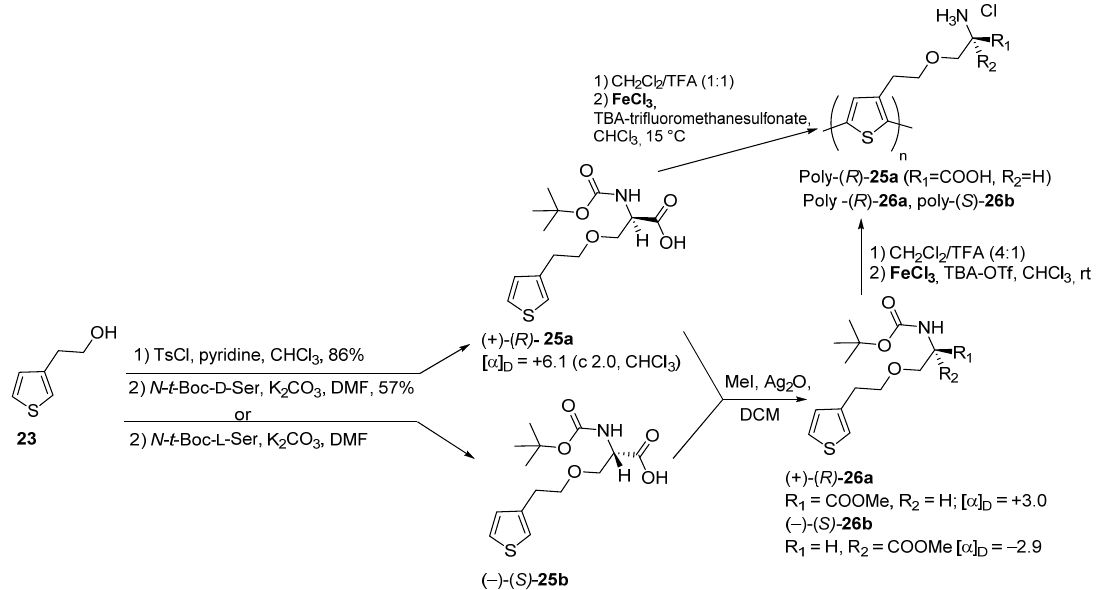
Scheme 7. Synthesis of 2- tert -Butoxycarbonylamino-3-(2-thiophen-3-yl-ethoxy)-propionic acid ( 25 ), its conversion to methyl ester analogue ( 26 ) and the polymerizations using FeCl 3 -mediated oxidative method.